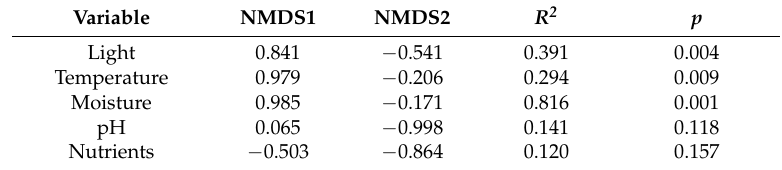
Table 1. Correlation coefficients of environmental variables with sample scores of NMDS axes 1 and